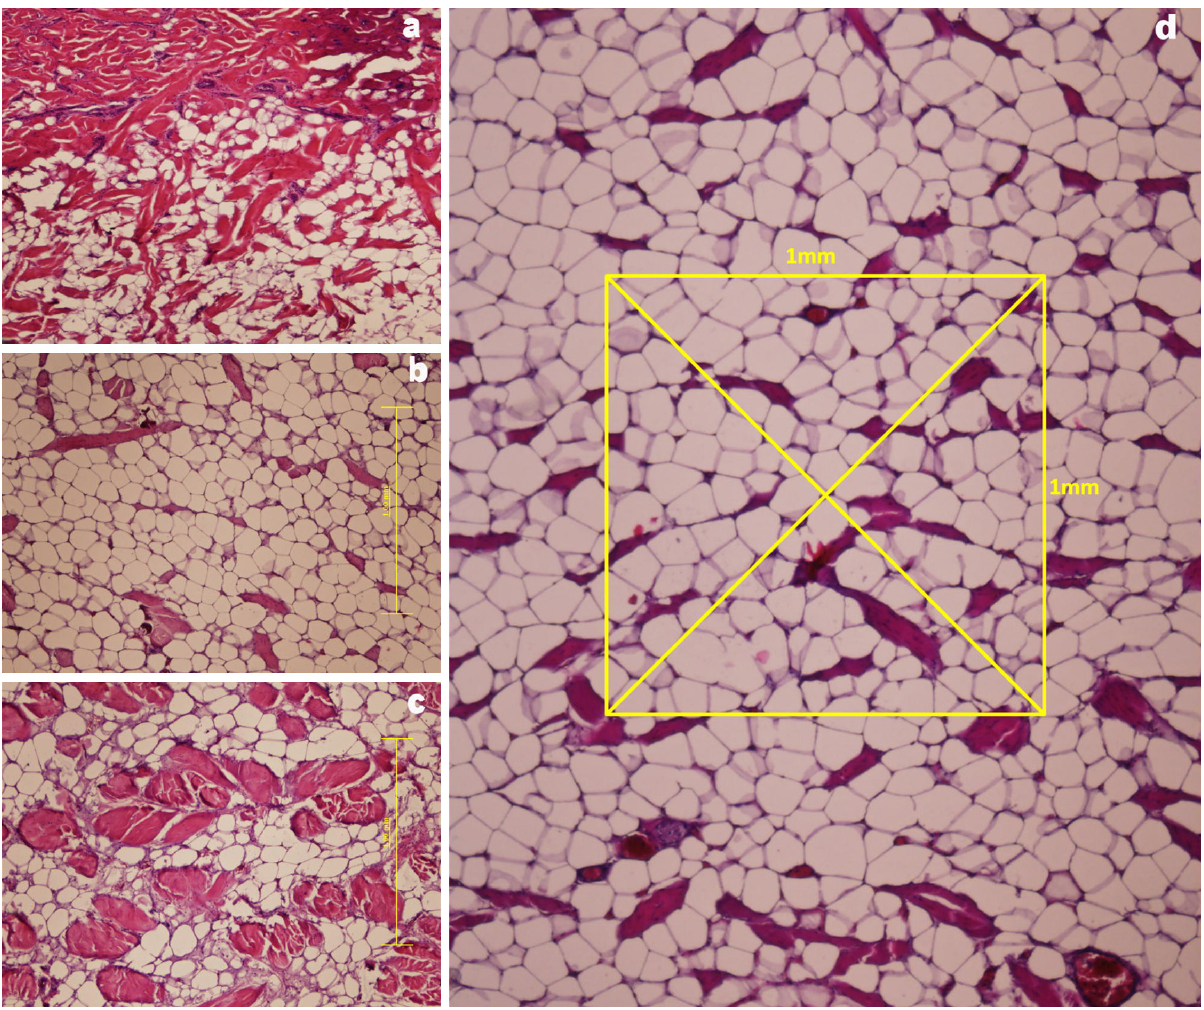
Fig. 2. – Representative hematoxylin and eosin slides of a blubber sample analysed showing the (A) outer, (B) middle, and (C) inner layers and (D) the 1×1 mm box containing diagonals used for quantitative histological